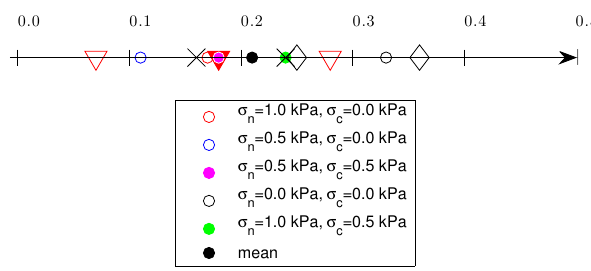
Figure 4. Exponent b of the power law fit at each set of loading conditions ( τ f ) compared to other studies ( × – Hobbs and Mason, 1964; ♦ – Blackford, 2007; O – van Herwijnen and Miller, 2013, where empty triangles – marginal values, H – the mean).